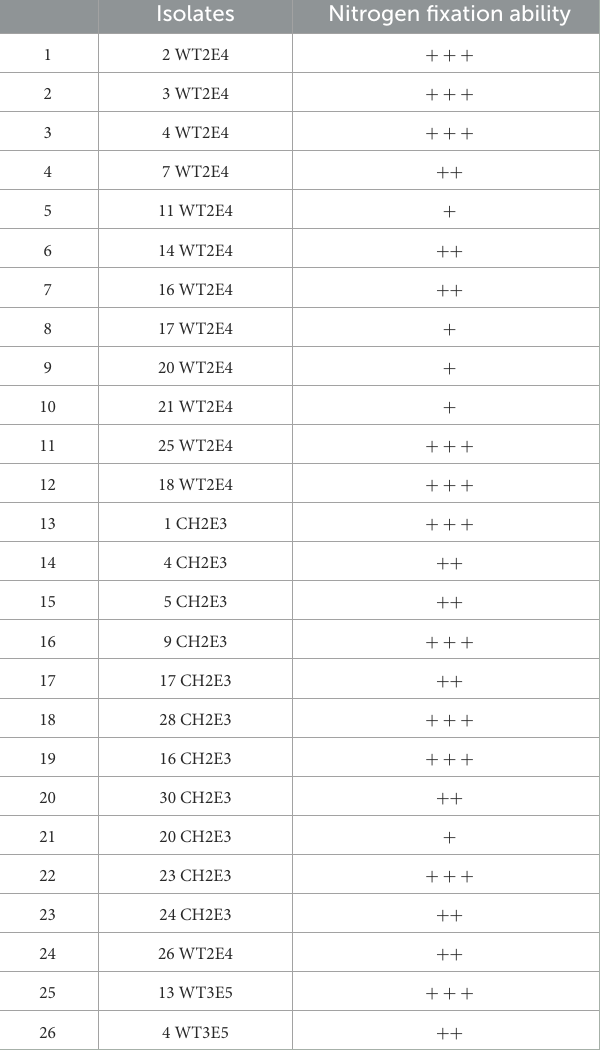
TABLE 1 Biological atmospheric N fixation potential according to different selected